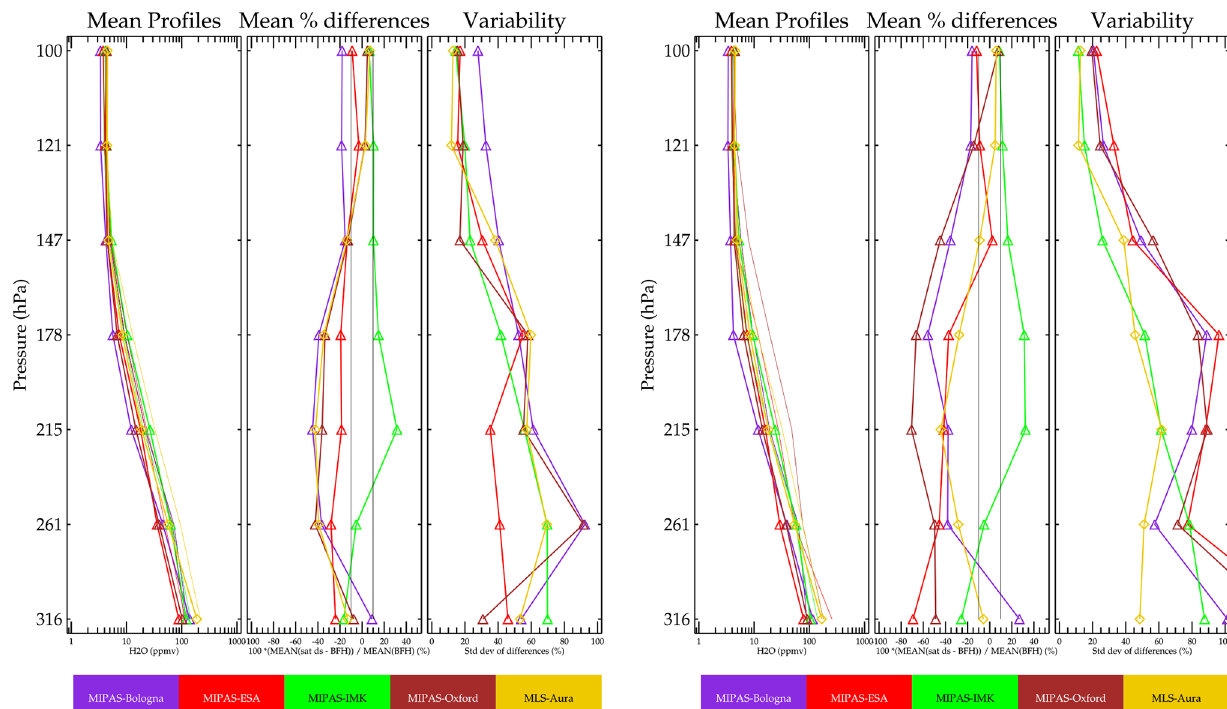
Figure 5. Summaries of coincident profile comparisons between Boulder BFH without averaging kernel applied (a) and with averaging kernel applied (b) as well as the satellite data sets. The data sets are color coded according to the caption below. The leftmost in the group of three panels shows the mean of the coincident profiles (thick with symbols) for the satellite data set and the corresponding mean for the BFH (thin line). The center panel within the triad shows the mean bias, and the right panel within the triad is the variability about the